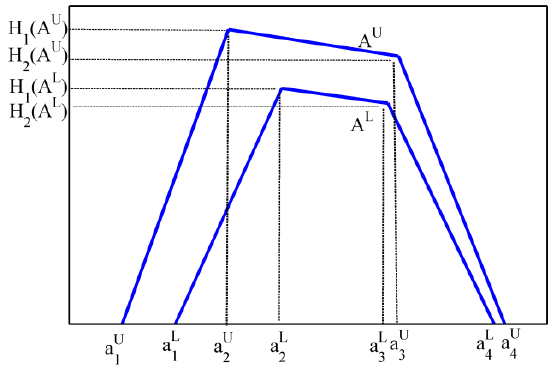
Figure 2. Primary membership function of trapezoidal IT2 FS.